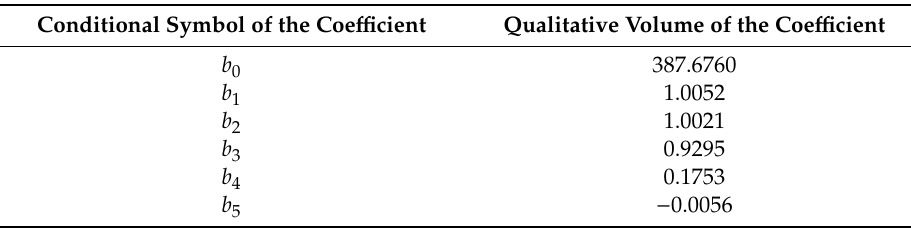
Figure 2. The subordination of the residues of the multifactorial linear model of joint value created in the maritime port sector to the normal distribution law (in Statistica 8.0).